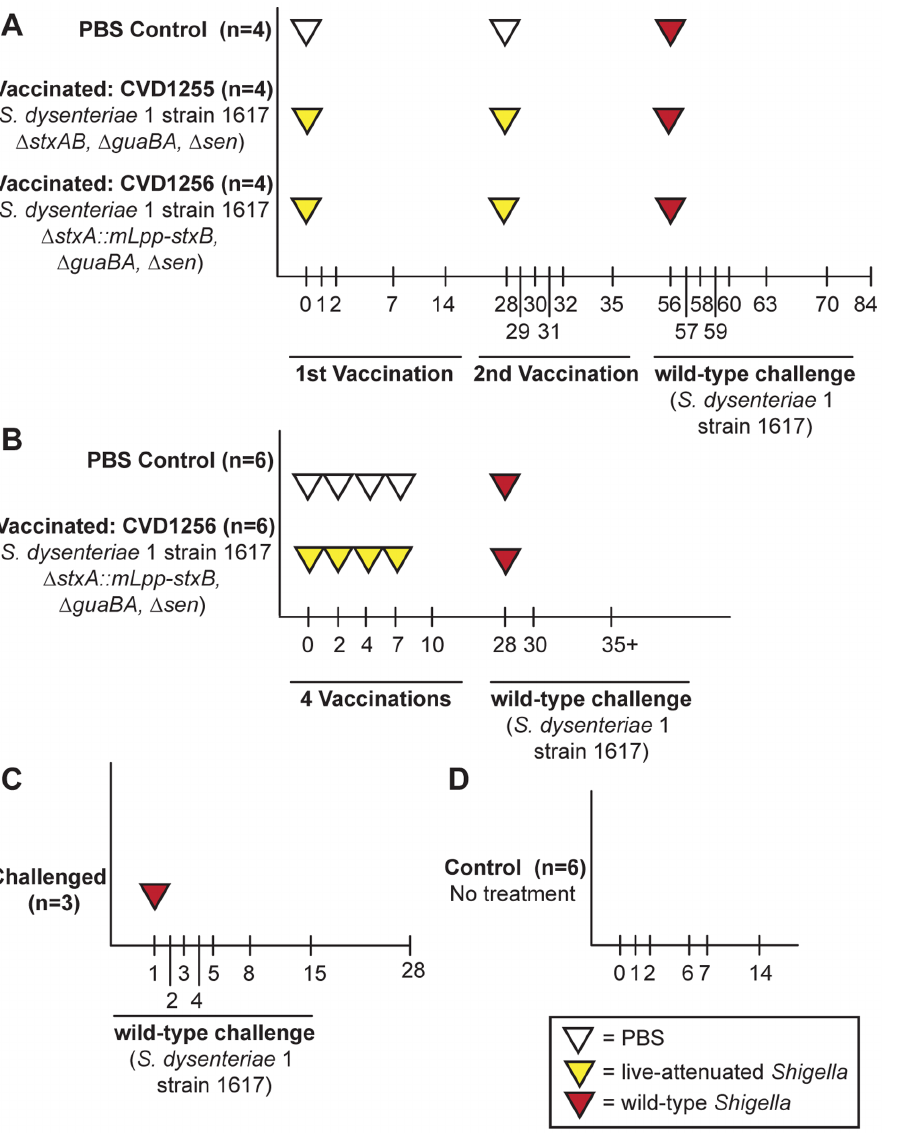
Figure 1. Experimental design for cynomolgus macaque studies. ( A ) Study 1. Macaques were immunized with live-attenuated S. dysenteriae 1 strain (CVD1256 or CVD1255) or mock-immunized with PBS on days 0 and 28, followed by wild-type S. dysenteriae 1 strain 1617 challenge on day 56. ( B ) Study 2. Macaques were immunized with CVD1256 or mock-immunized with PBS on days 0, 2, 4, and 7, followed by wild-type challenge with S. dysenteriae 1 strain 1617 on day 28. ( C ) Study 3. Macaques were challenged with wild-type S. dysenteriae 1 strain 1617. ( D ) Study 4.